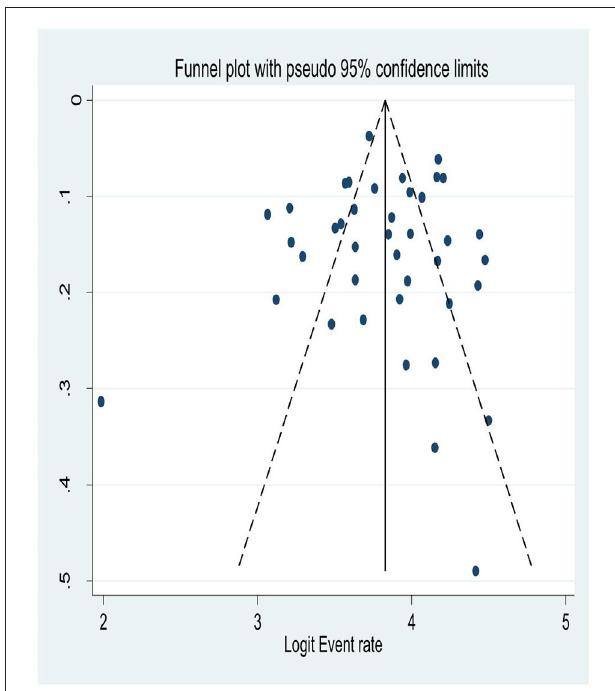
FIGURE 6 | A funnel plot for the prevalence of HIV associated neurocognitive